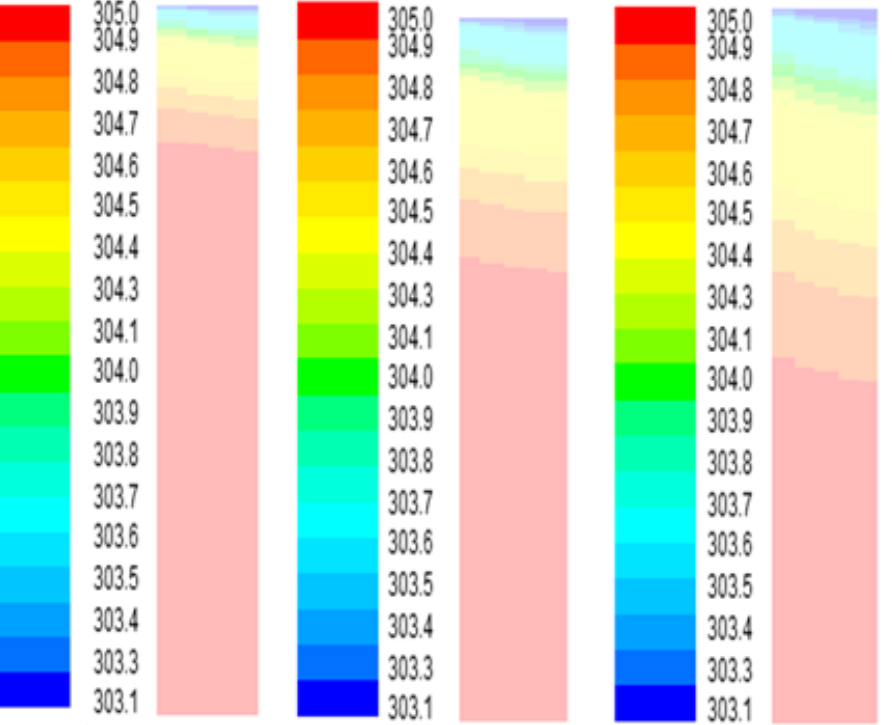
Figure 7. Comparison of the temperature contour (K) obtained numerically for pure water with Re = 600, 1200 and 1800, respectively.